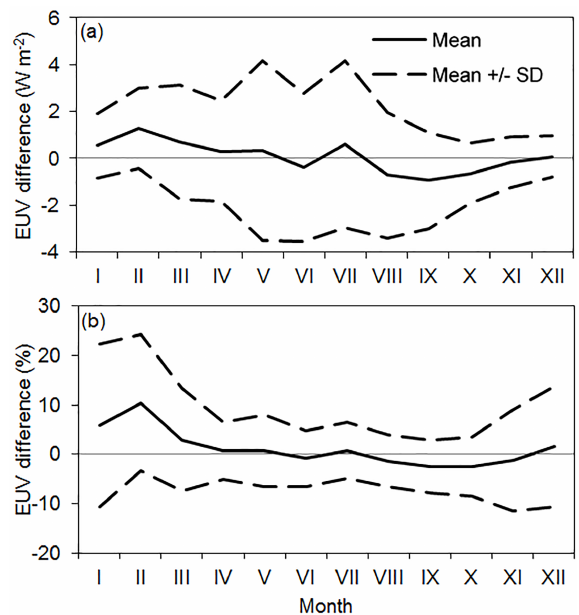
Figure 1. The mean (a) absolute and (b) relative differences be- tween the observed and modeled EUV irradiance and their standard deviations (SD) at the Hradec Králové observatory in the period